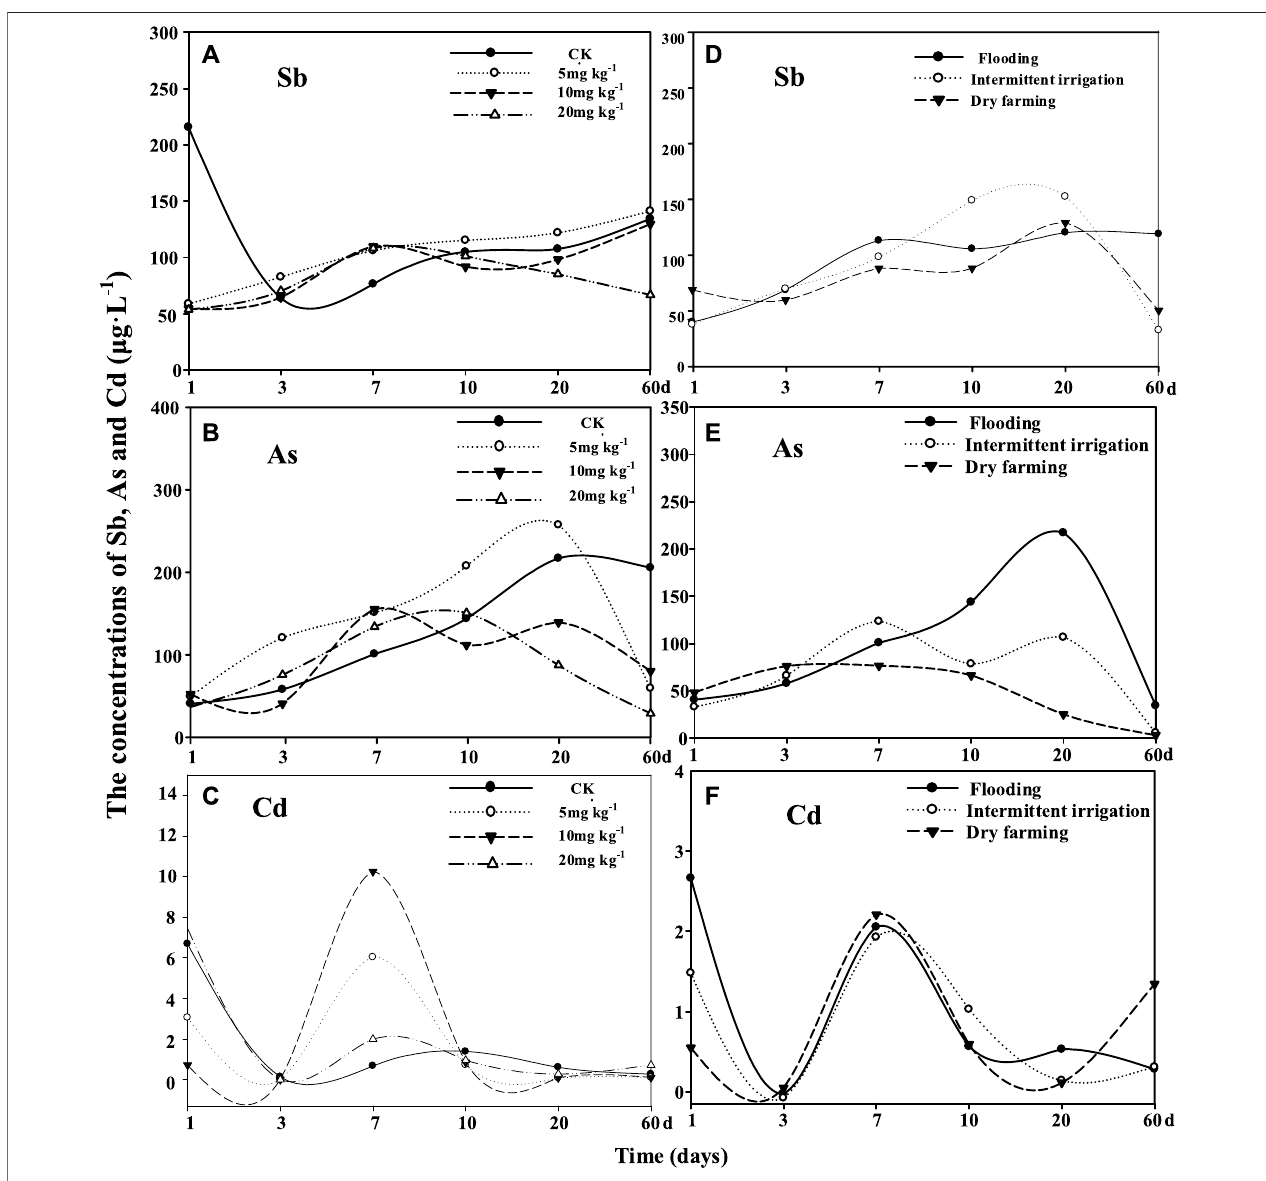
FIGURE 1 | Dynamic changes of Sb, As, and Cd concentrations in the soil solution with the elongation of time. Panels (A – C) indicates the changes of Sb, As, and Cd concentrations in the soil solution under different FeCl 3 treatments, respectively. Panels (D – F) indicate the changes of Sb, As and Cd concentrations in the soil solution under the fl ooding, intermittent irrigation, and dry farming treatments,